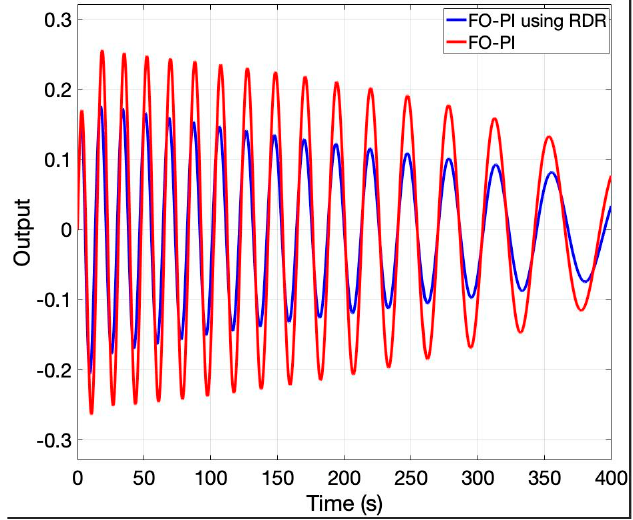
Figure 20. Disturbance rejection results for a higher-order process considering a swept sinusoidal disturbance signal with frequencies in [0.5 ω d , 2 ω d ] (red line—FO-PI designed by Gude 2010).